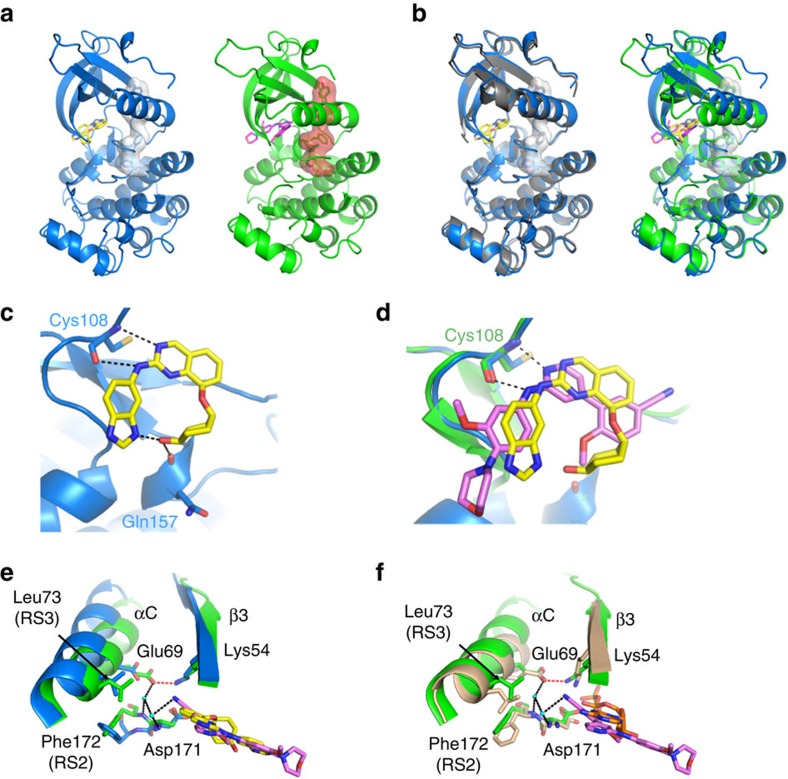
Structural basis of TNIK inhibition.(a) The crystal structures of NCB-0846-bound and Compound 9-bound TNIK-KDs (blue and green). NCB-0846 (yellow) and Compound 9 (magenta) are shown by sticks. The hydrophobic R-spine residues are shown by sticks with surface representations (white and red). (b) Superimpositions of apo TNIK-KD (grey, left panel) or Compound 9-bound TNIK-KD (green, right panel) onto NCB-0846-bound TNIK-KD (blue). (c) NCB-0846 in the ATP-binding site of TNIK-KD. Hydrogen bonds are indicated by dashed lines. (d) Comparison of Compound 9 (magenta) and NCB-0846 (yellow) binding sites. (e) Differences in αC-helix position and DFG motif between NCB-0846-bound TNIK-KD (blue) and Compound 9-bound TNIK-KD (green). In Compound 9-bound TNIK-KD, the Lys54/Glu69 salt bridge (red dashed line, 2.7 Å) and the hydrogen bonding network (black dashed lines) mediated by water molecules (cyan balls) are indicated. (f) Superimpositions of Compound 9-bound TNIK-KD (green) onto the active state of PKA (wheat) bound to ATP (orange sticks).